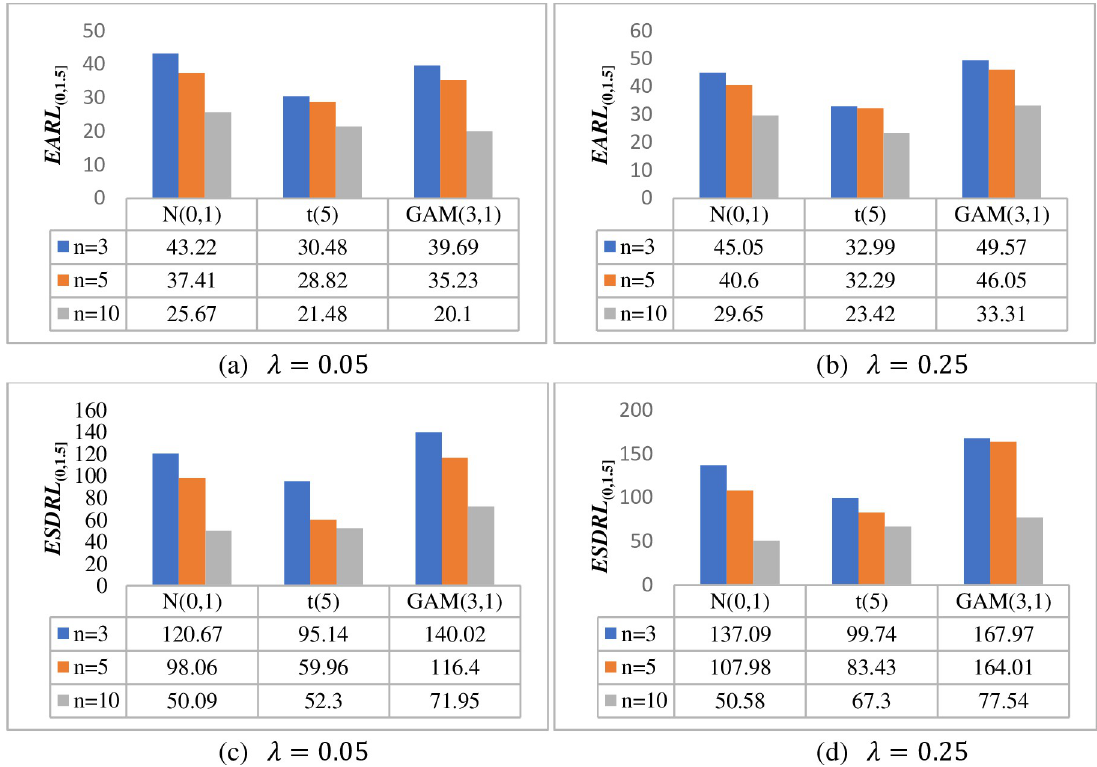
Fig 1. Effect of the phase II sample size on the overall performance of the HWMA W scheme when m = 100, λ 2 {0.05, 0.25} and n 2 {3, 5, 10} under N (0,1), t (5) and GAM (3,1) distributions.